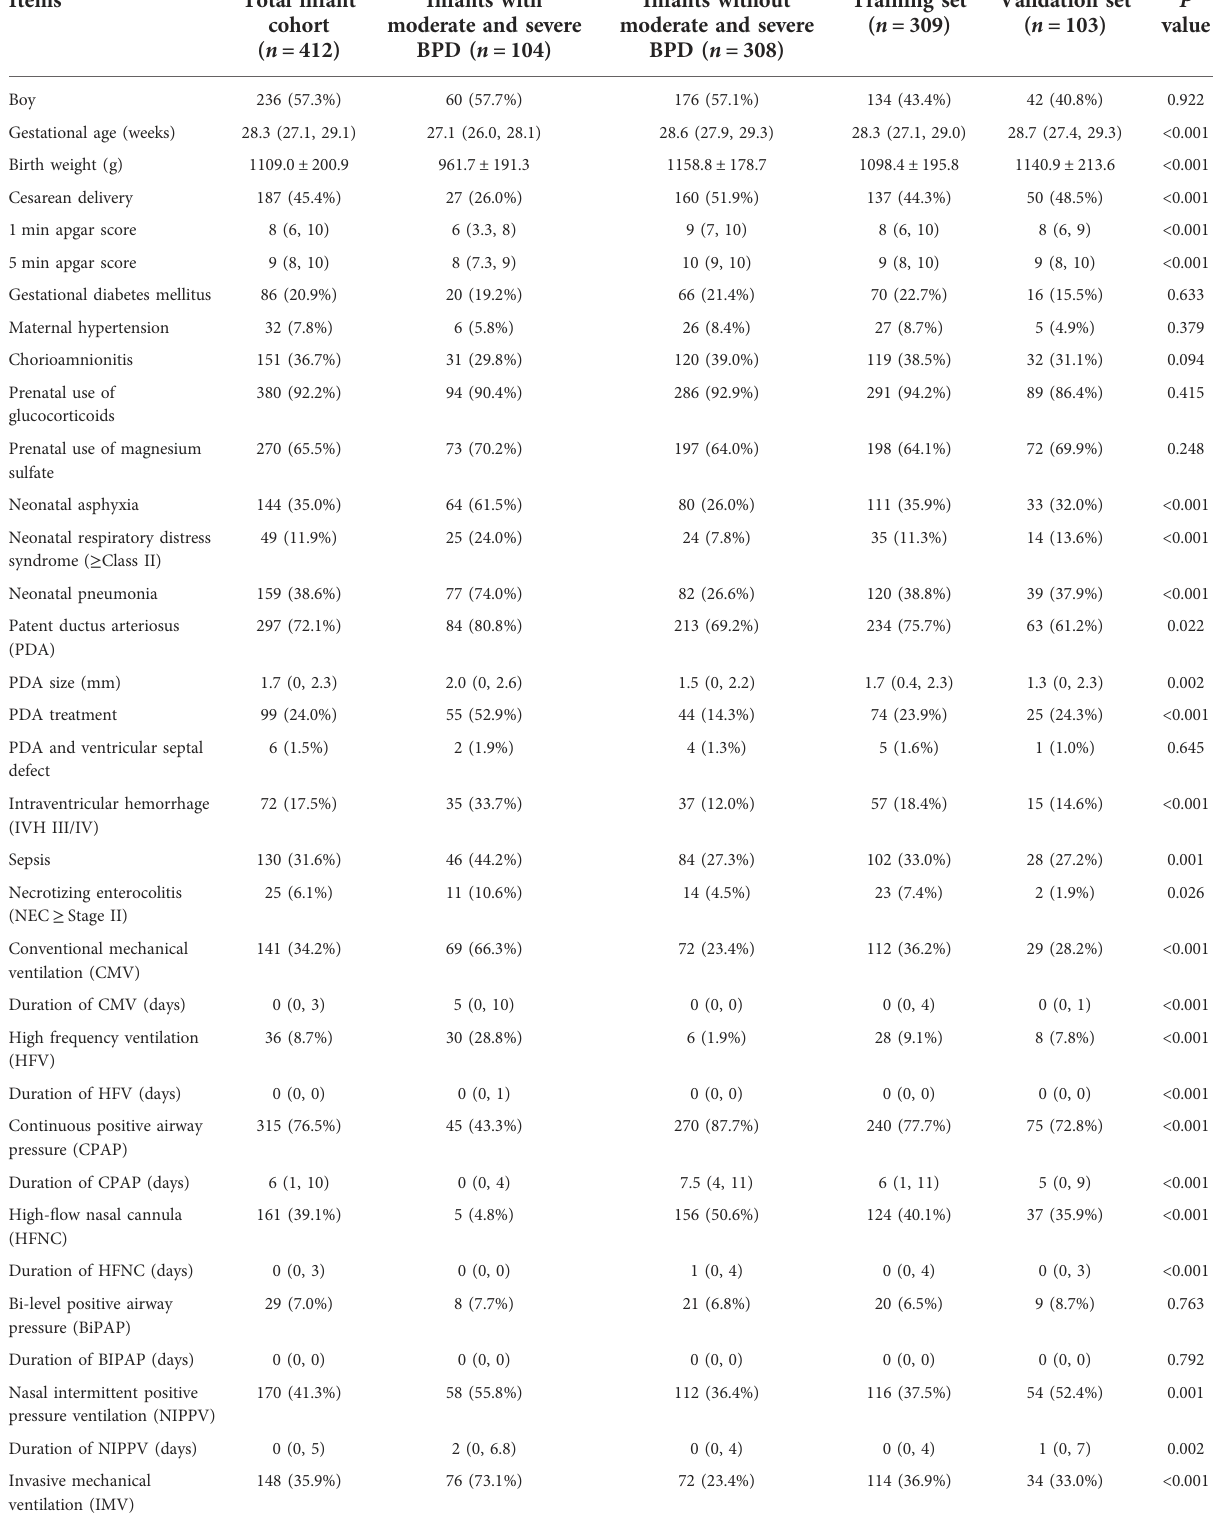
TABLE 1 Characteristics of the 412 preterm infants with gestational age <30 weeks and birth weight <1,500 g enrolled in the study according to presence/absence of moderate and severe bronchopulmonary dysplasia (BPD) and randomization to training set and validation set.